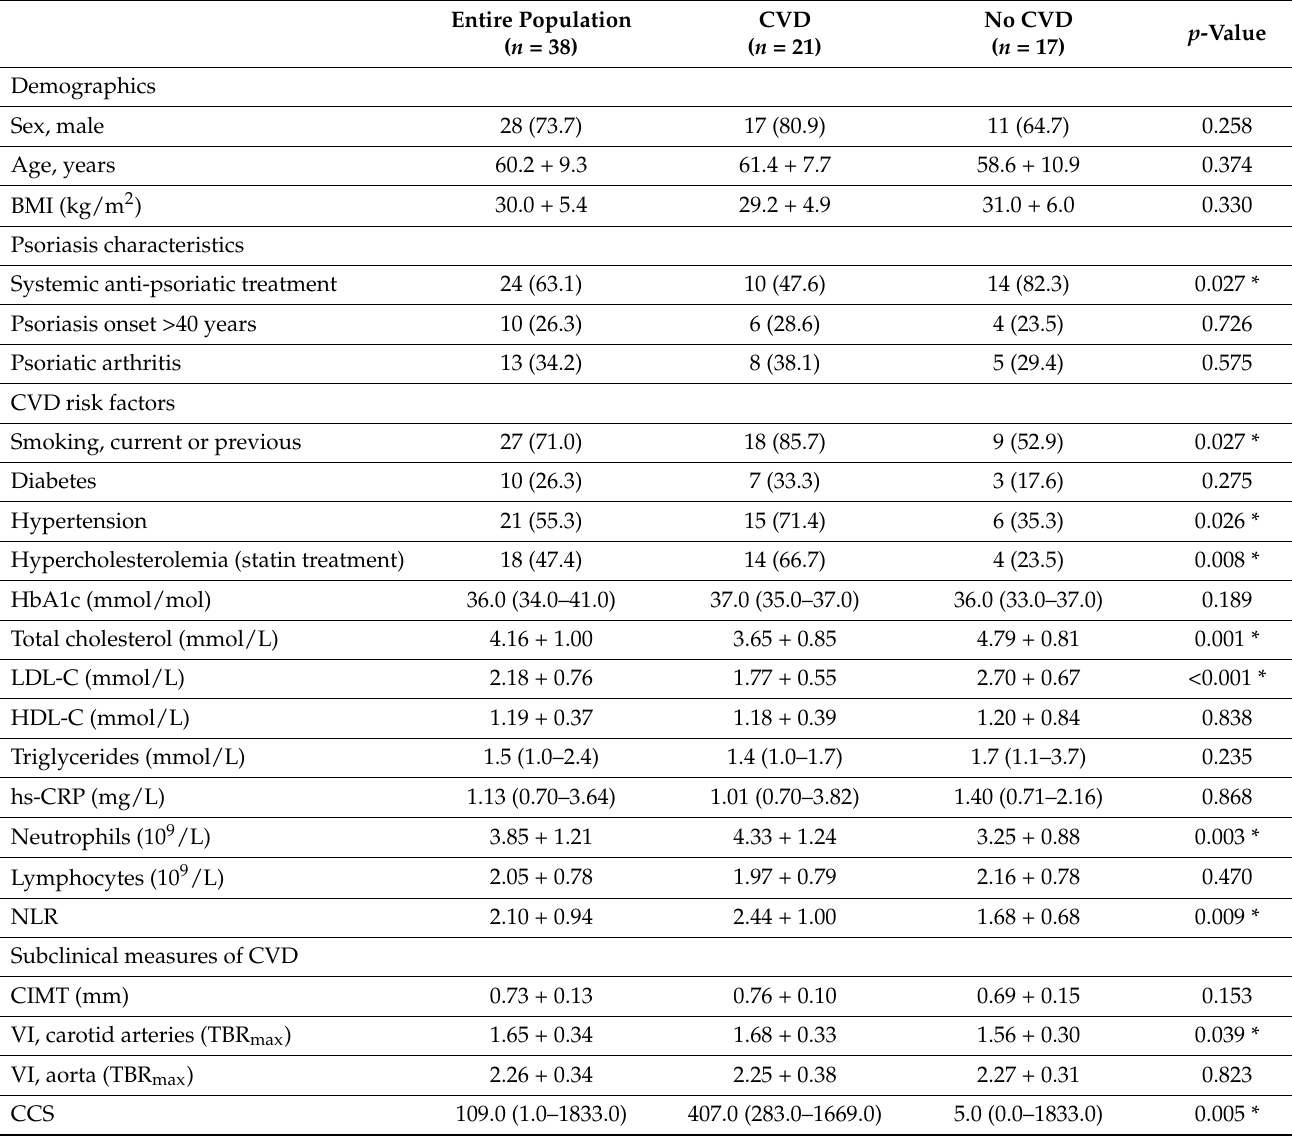
Table 1. Baseline characteristics of study